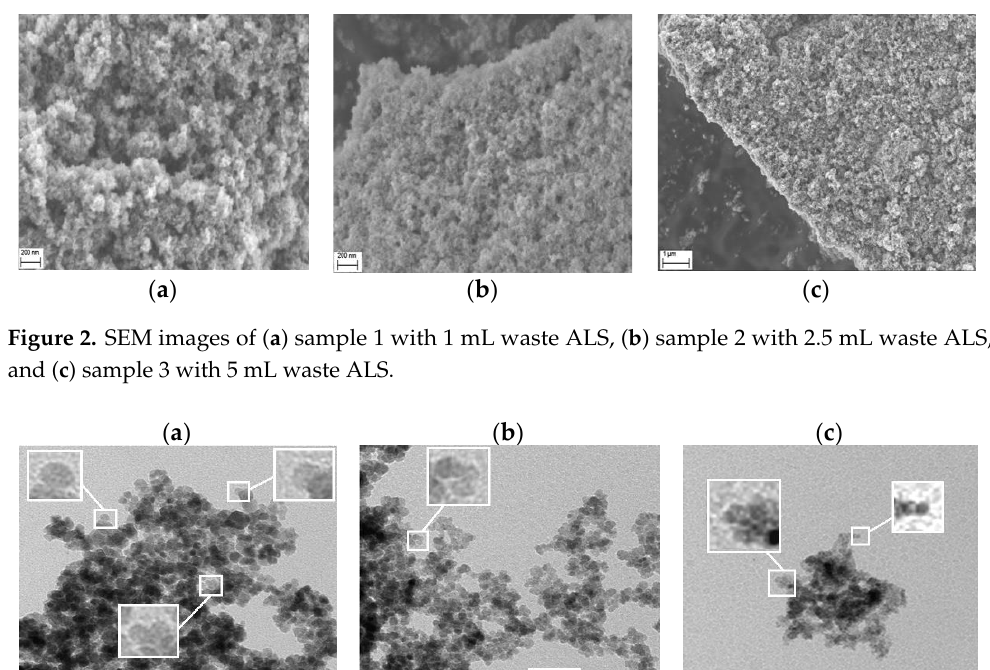
Figure 2. SEM images of ( a ) sample 1 with 1 mL waste ALS, ( b ) sample 2 with 2.5 mL waste ALS, and ( c ) sample 3 with 5 mL waste ALS.